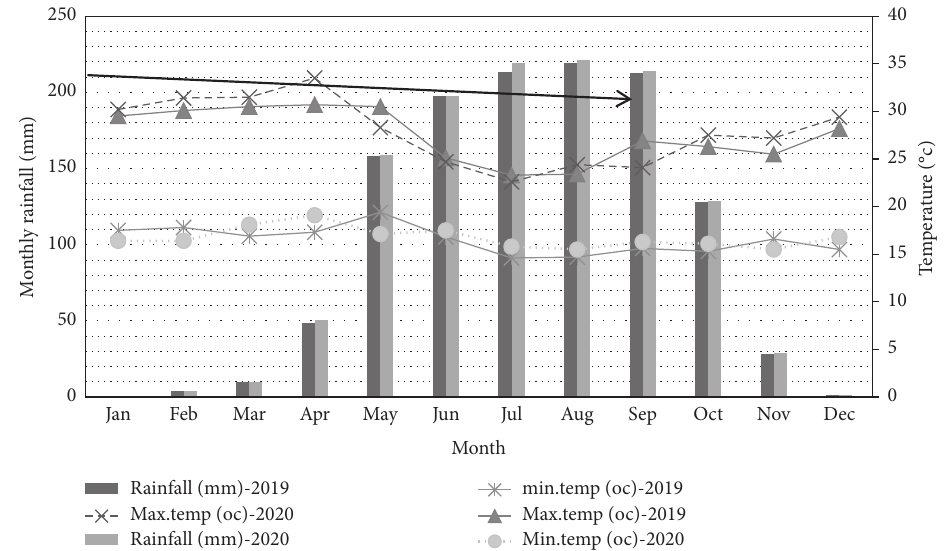
Figure 1: Average monthly rainfall and temperature distribution during 2019 and 2020 experimental years in Assosa.